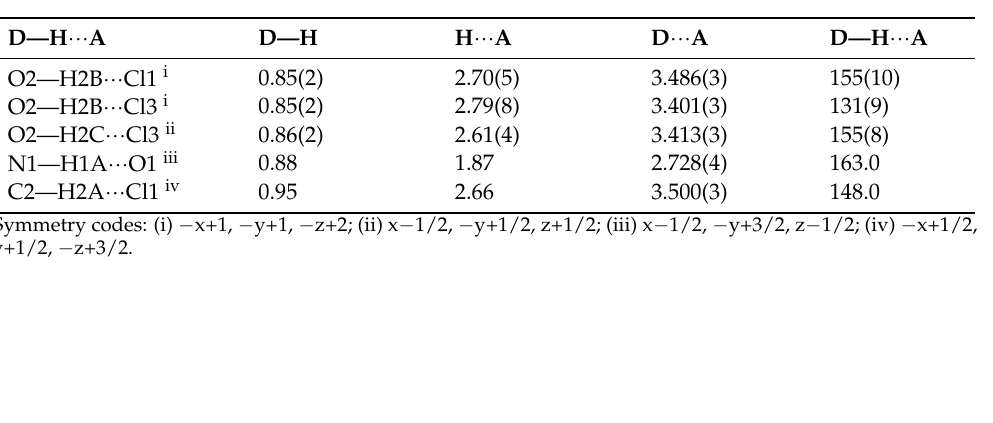
Table 3. Selected geometric parameters (Å, °) for II.